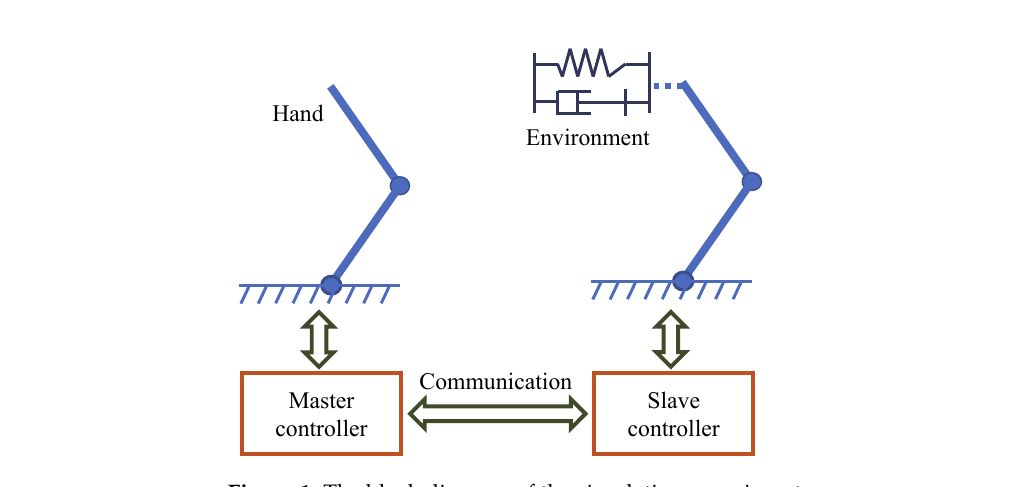
Figure 1. The block diagram of the simulation experiment.